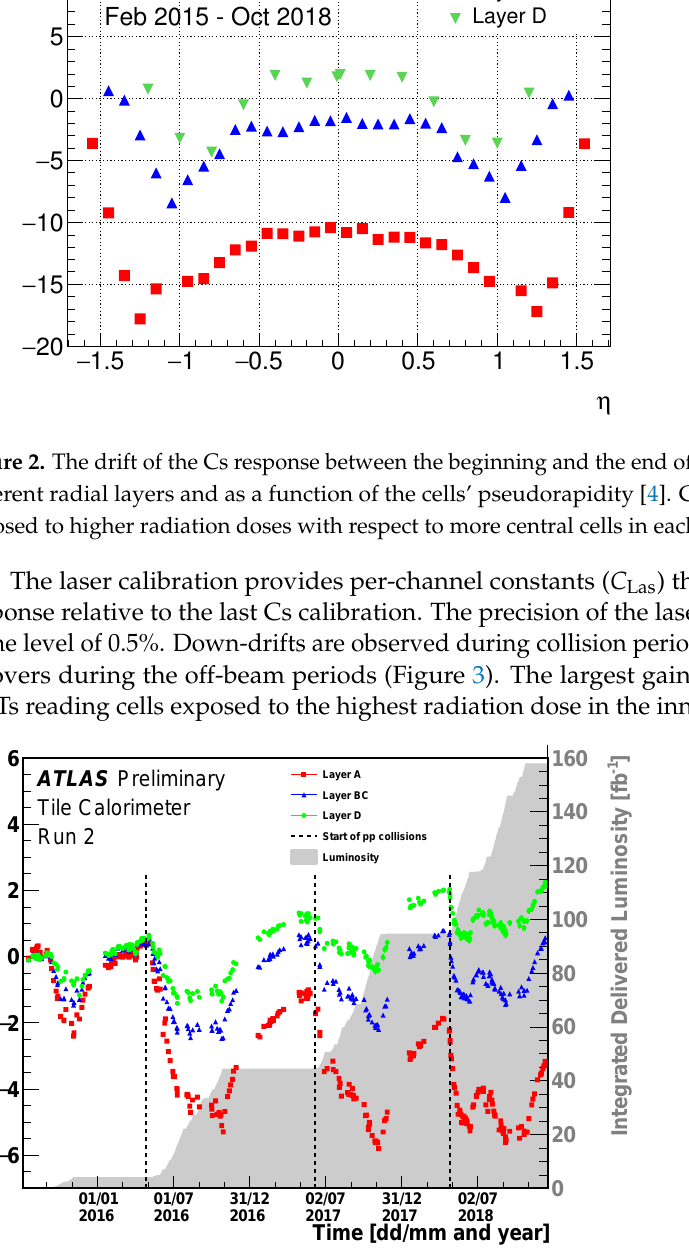
Figure 3. The evolution of the mean relative laser response of three radial layers as a function of time. The dashed lines indicate the beginning of the pp collision period in each year